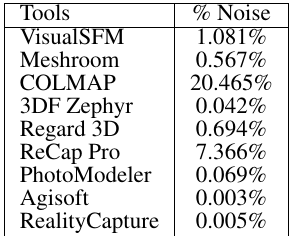
Table 6. Percentage noise of generated